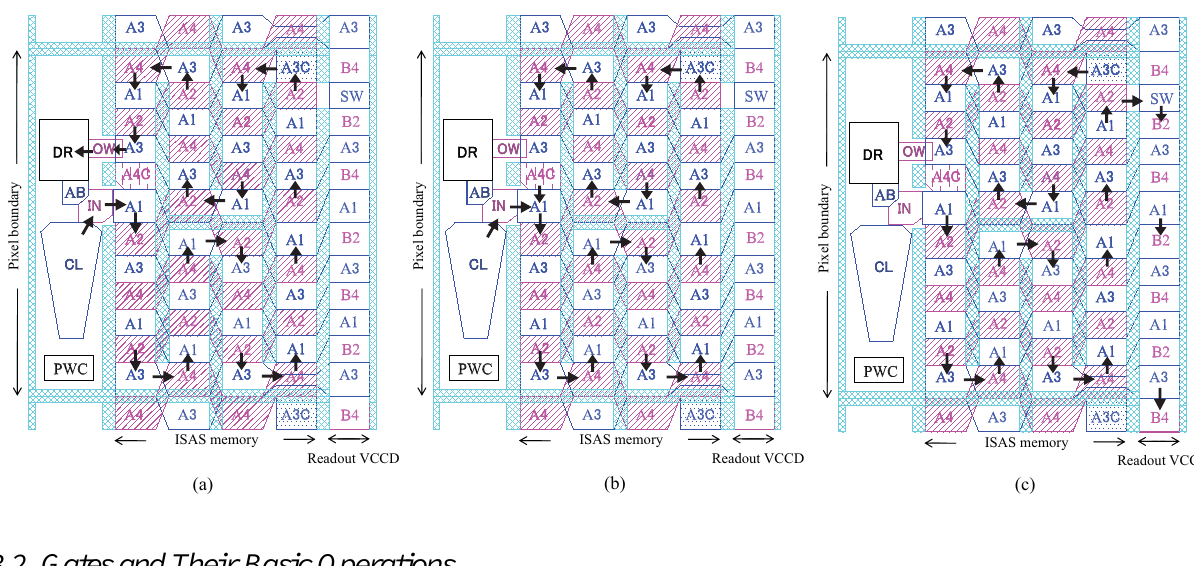
Figure 10. Operation schemes of CCD-ISAS: (a) Continuous overwriting mode; (b) Signal accumulation (ISAS) mode; (c) Readout mode. For abbreviation, see Appendix